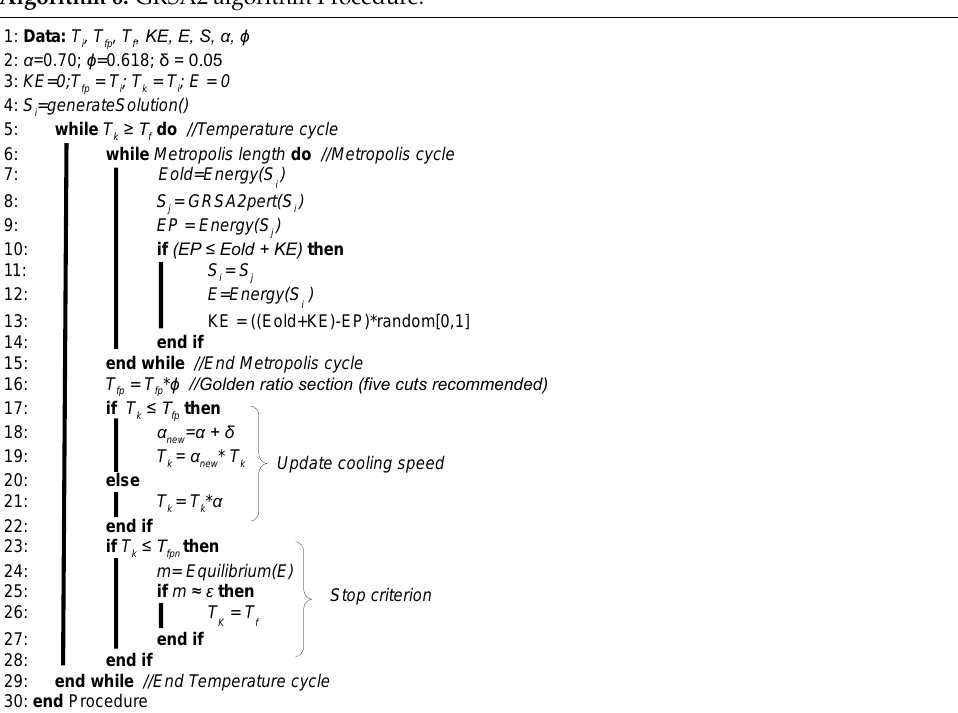
Algorithm 6. GRSA2 algorithm Procedure. Algorithm 4 GRSA2 algorithm Procedure